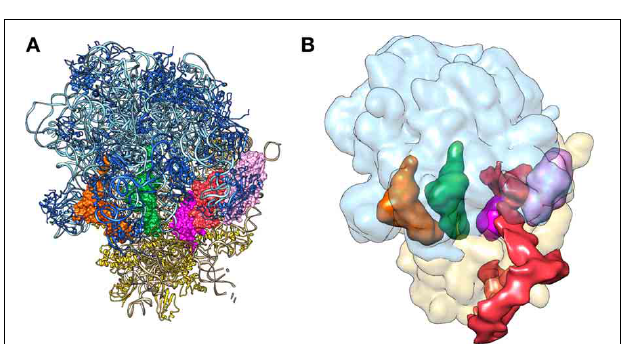
FIGURE 9 | The pre-accommodation step of trans -translation as solved by X-ray diffraction and to cryo-electron microscopy. (A) Crystal structure of the alanyl-TLD-SmpB-EF-Tu • GDP quaternary complex bound to a stalled ribosome (Neubauer et al., 2012) (PDB entries 4ABR 4ABS). (B) Cryo-EM map of the alanyl-tmRNA-SmpB-EF-Tu • GTP quaternary complex bound to a stalled ribosome (Valle et al., 2003) (EMDB entry: EMD-1312). Color code: tmRNA or TLD is red; SmpB is magenta; the small 30S subunit is yellow; the large 50S subunit is light blue; the E-Site tRNA is orange; the P-site tRNA is green; and the EF-Tu is